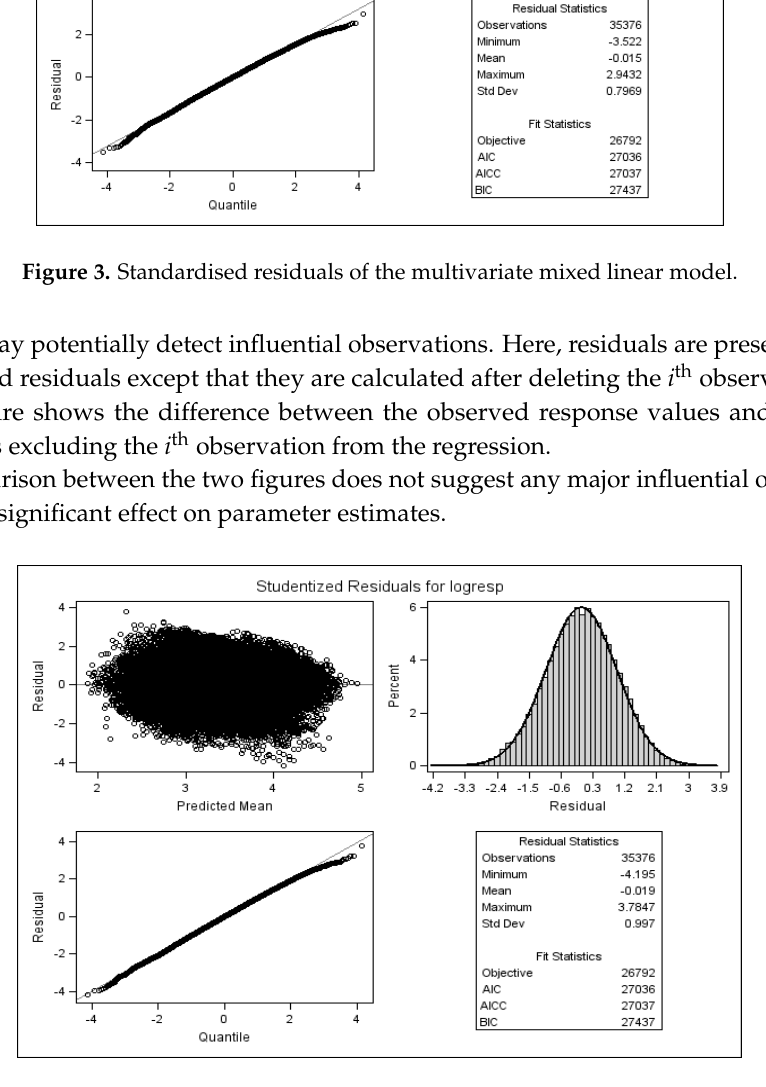
Figure 4. Standardised residuals with the i t h observation removed.